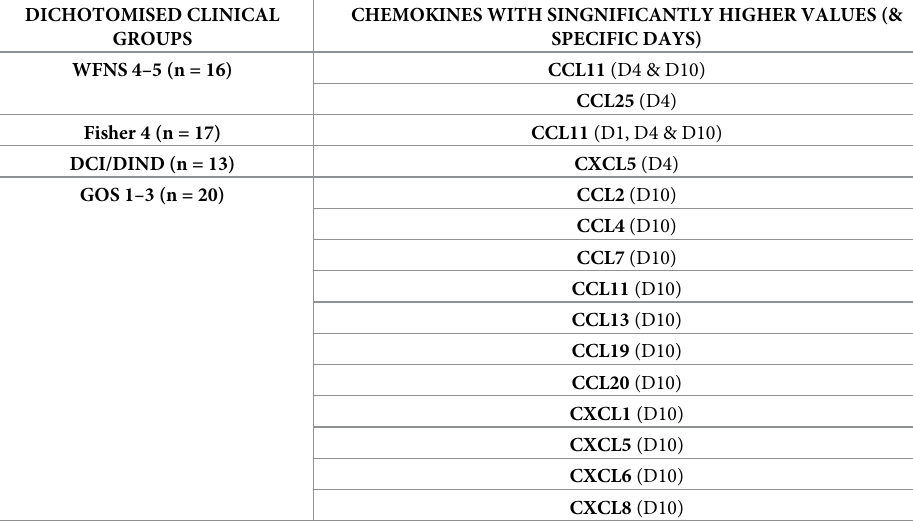
Table 2. Comparison of chemokine expression levels in dichotomized patient